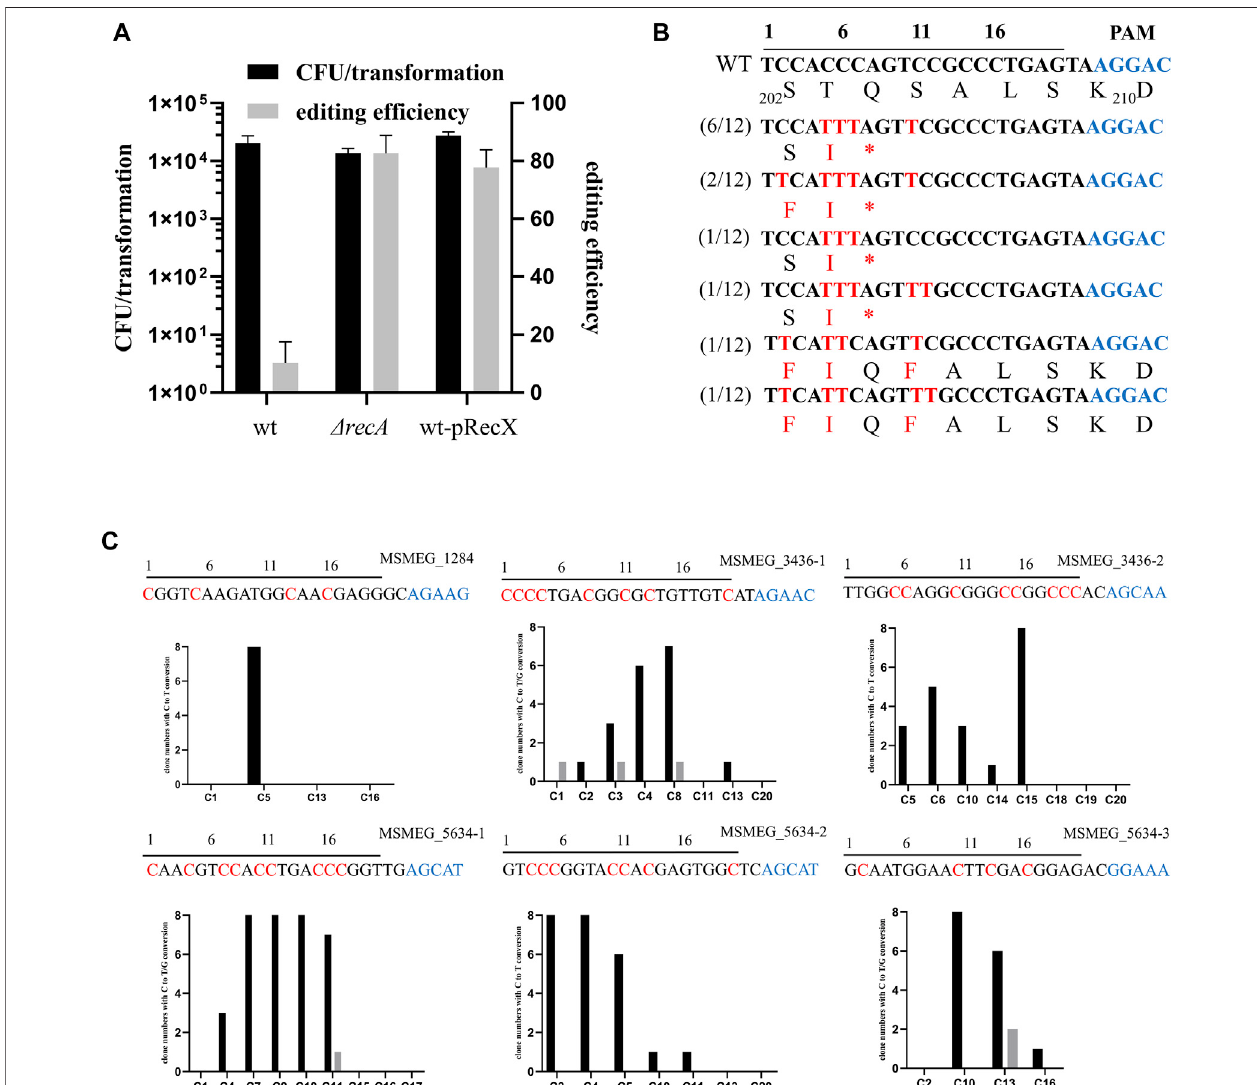
FIGURE 2 | RecX affects the ef fi ciency of single base editing. (A) recA deletion and recX overexpression increase the editing ef fi ciency of CBE. (B) Sequence alignments of the targeted loci. Black line over the alignment indicates gfp sgRNA and PAM motif is shown in blue. The targeted sites from 12 randomly-picked clones edited by APOBEC1-nCas9 sth1 -UGI were sequenced and aligned. The mutated bases and amino acids are shown in red. (C) Examination of the editing window of the CBE system in M. smegmatis . Six spacers were assembled into the pCBE plasmid, respectively. The resulted plasmids were transformed into the M. smegmatis strain. Eightrandomly-picked clones from each target were sequenced and the number of clones with edited C at different positions were counted. C to T conversion is coloredblackandCtoGconversioniscoloredgrey.BlacklineoverthealignmentindicatessgRNAspacersandPAMmotifisshowninblue.TheexpectededitingCsare indicated by